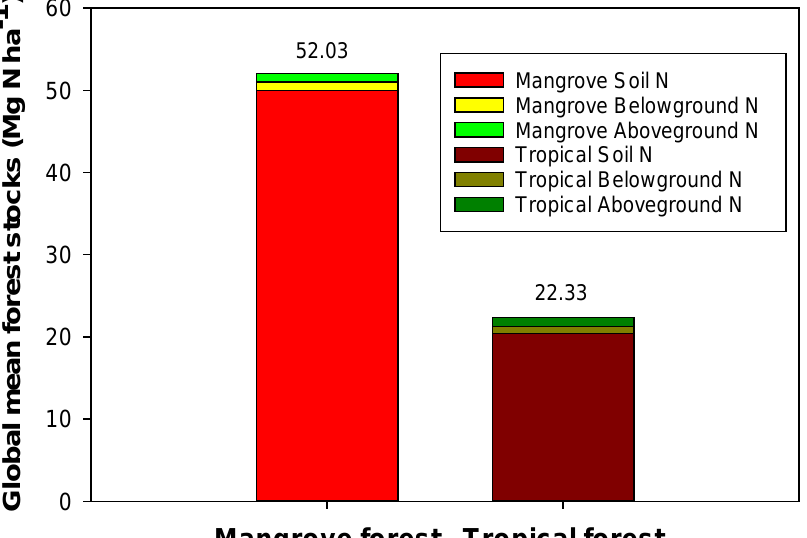
Figure 2. Mean TN stocks in mangrove above- and belowground biomass and soils to a depth of 1 m. Biomass and soil dry weight data extrapolated to N using N content or C / N ratios ( g / g ) in Table 1. Tropical terrestrial forest data are presented for comparison and includes data from moist forests, peat swamp forests, and rain forests with N, C and C / N ( g / g ) data [16–38,113–120] and earlier references within.